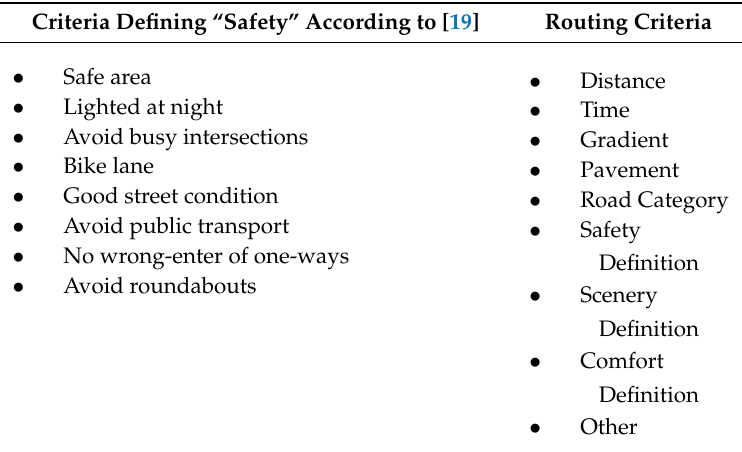
Table 1. The portals were evaluated with regard to the following routing criteria.